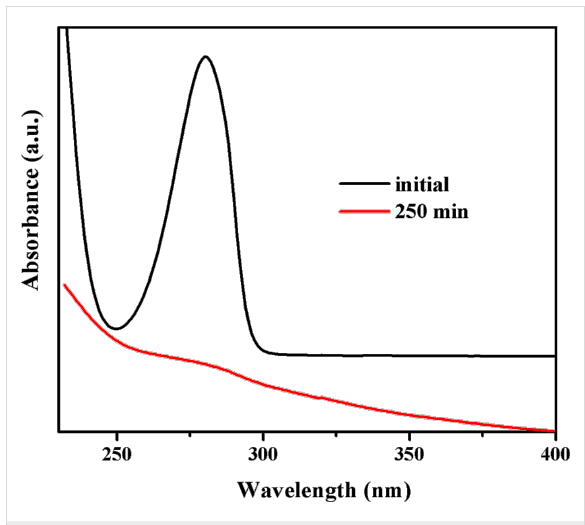
Figure 12: UV–vis absorption spectra of an aqueous dopamine solu- tion before and after 250 min of visible-light irradiation in the presence of TiO 2 /SiO 2 /Fe 2 O 3